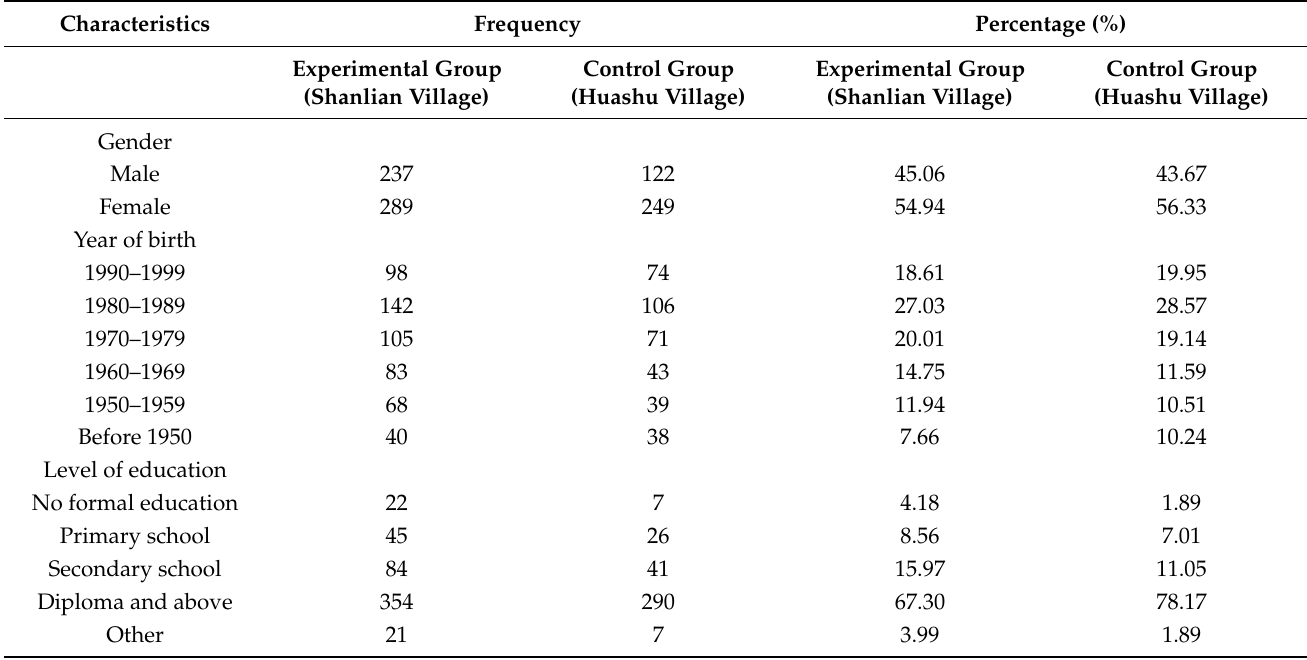
Table 2. Profile of